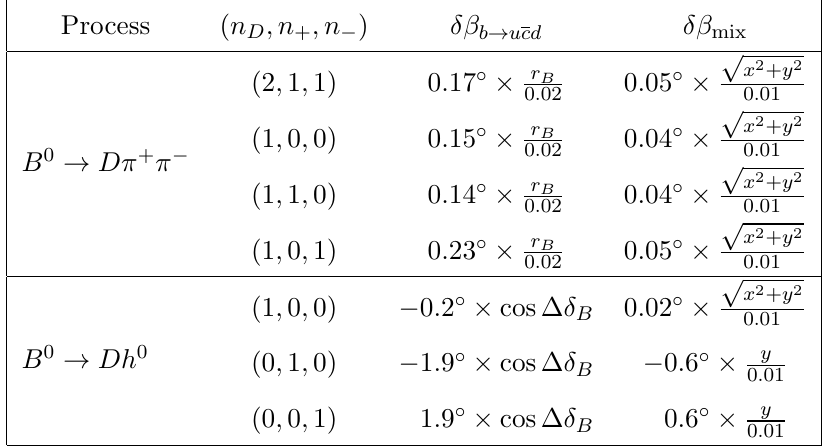
ucd transition (3 rd ! K 0 (cid:25) + (cid:25) (cid:0) , D 0 f CP + and D 0 f CP(cid:0) S ! ! !